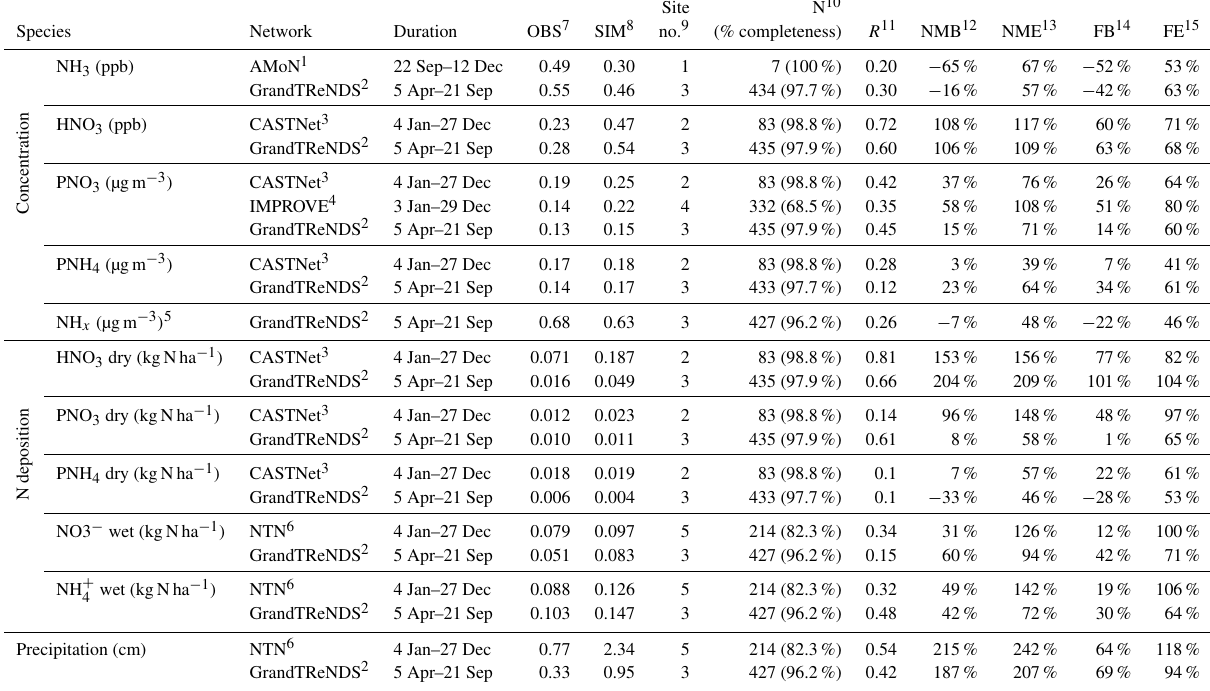
1 AMoNsamplesarecollectedfor2weeks. 2 CASTNetsamplesarecollectedfor1week. 3 GrandTReNDSsamplesarecollecteddaily. 4 IMPROVE24hsamplesarecollectedevery3days. 5 NH x = NH 3 + PNH 4 . 6 NTNsamplesarecollectedfor1week. 7 Averageobservation. 8 Averagesimulation. 9 Numberofsites. 10 Numberofsamples;thevaluesintheparenthesesarethepercentageofvalidsamplesusedformodel performanceevaluation. 11 Pearson’scorrelationcoefficient. 12 Normalizedmeanbias. 13 Normalizedmeanerror. 14 Fractionalbias. 15